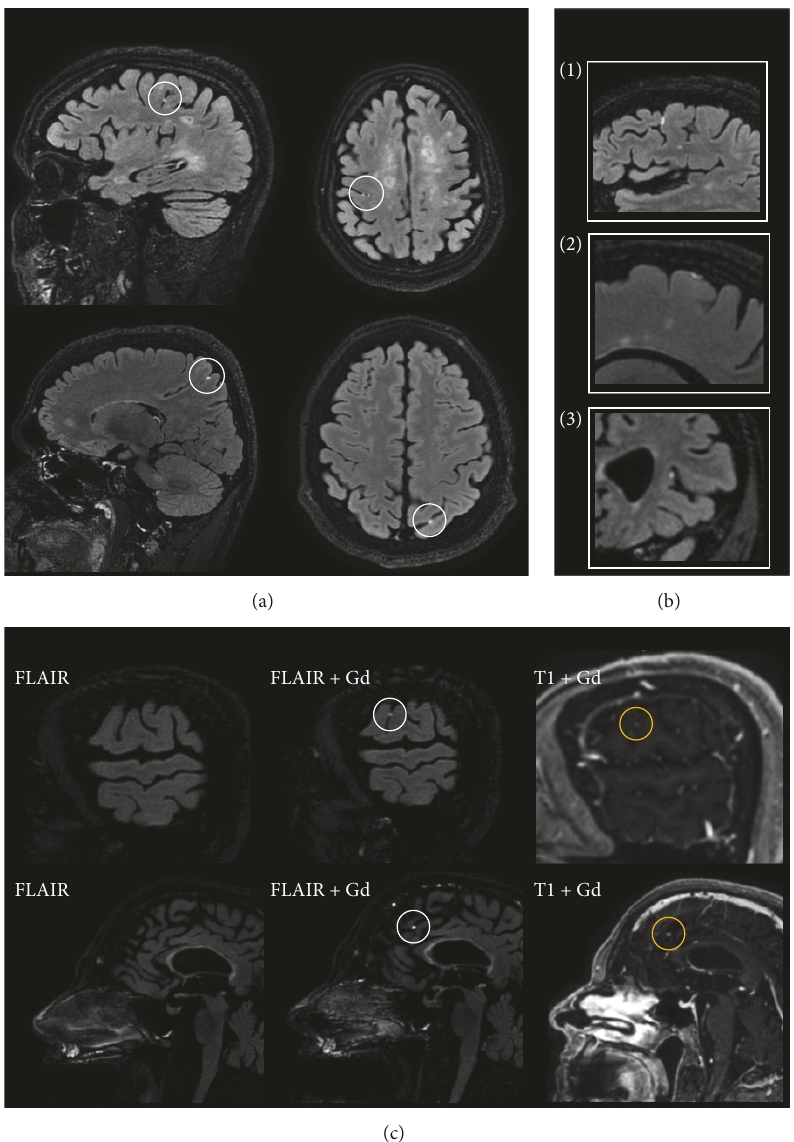
Figure 1: Main characteristics of LMCE. (a) Examples of localizations of LMCE on whole-brain images; (b) presentations of different types of LMCE foci: ( 1 ) linear, ( 2 ) plate-like, ( 3 ) nodular; (c) relationship between LMCE foci on precontrast FLAIR and postcontrast T1 and